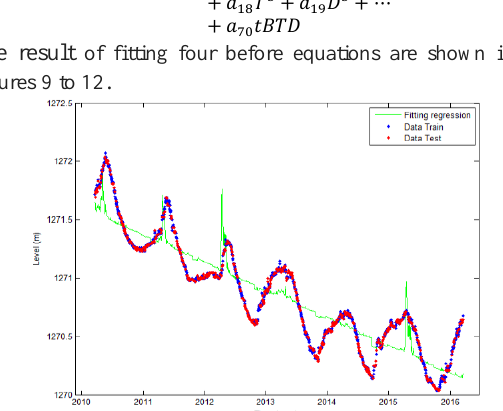
Figure 9: The regression graph of 1 st degree of polynomial